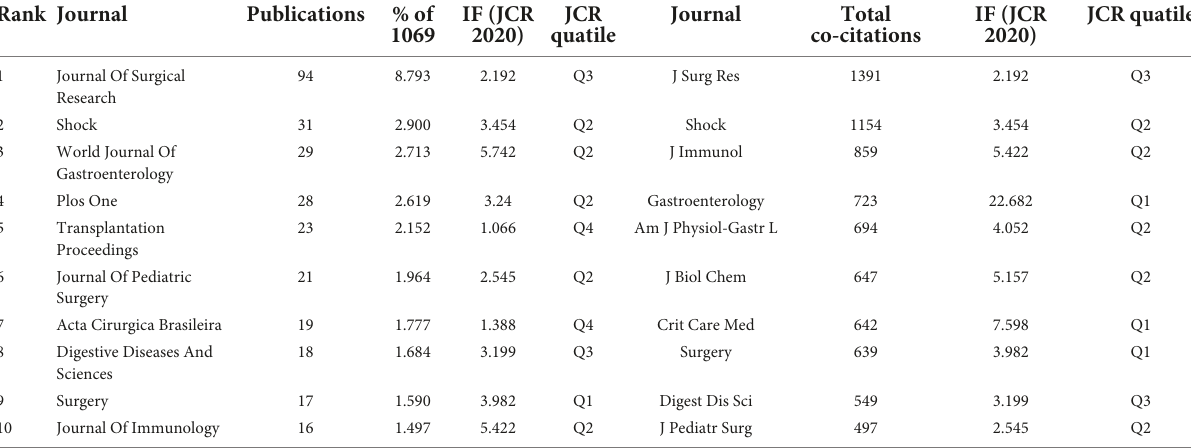
TABLE 4 Top 10 journals in terms of number of issues and co-citation